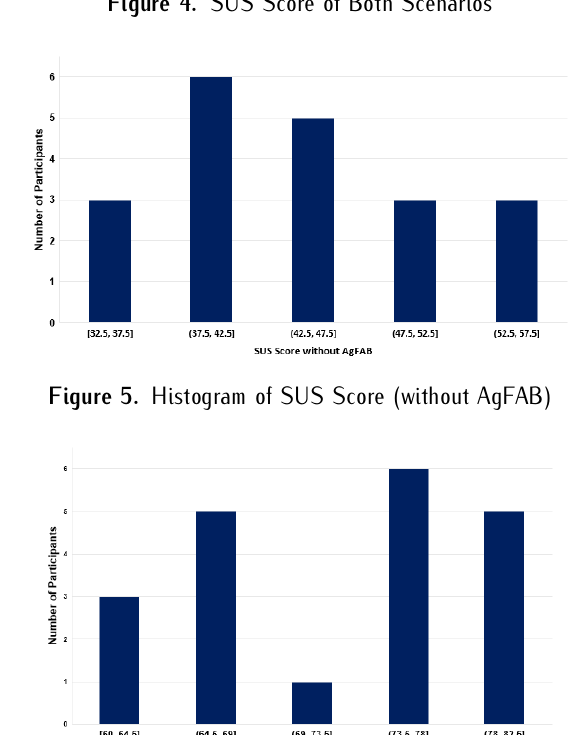
Figure 4. SUS Score of Both Scenarios